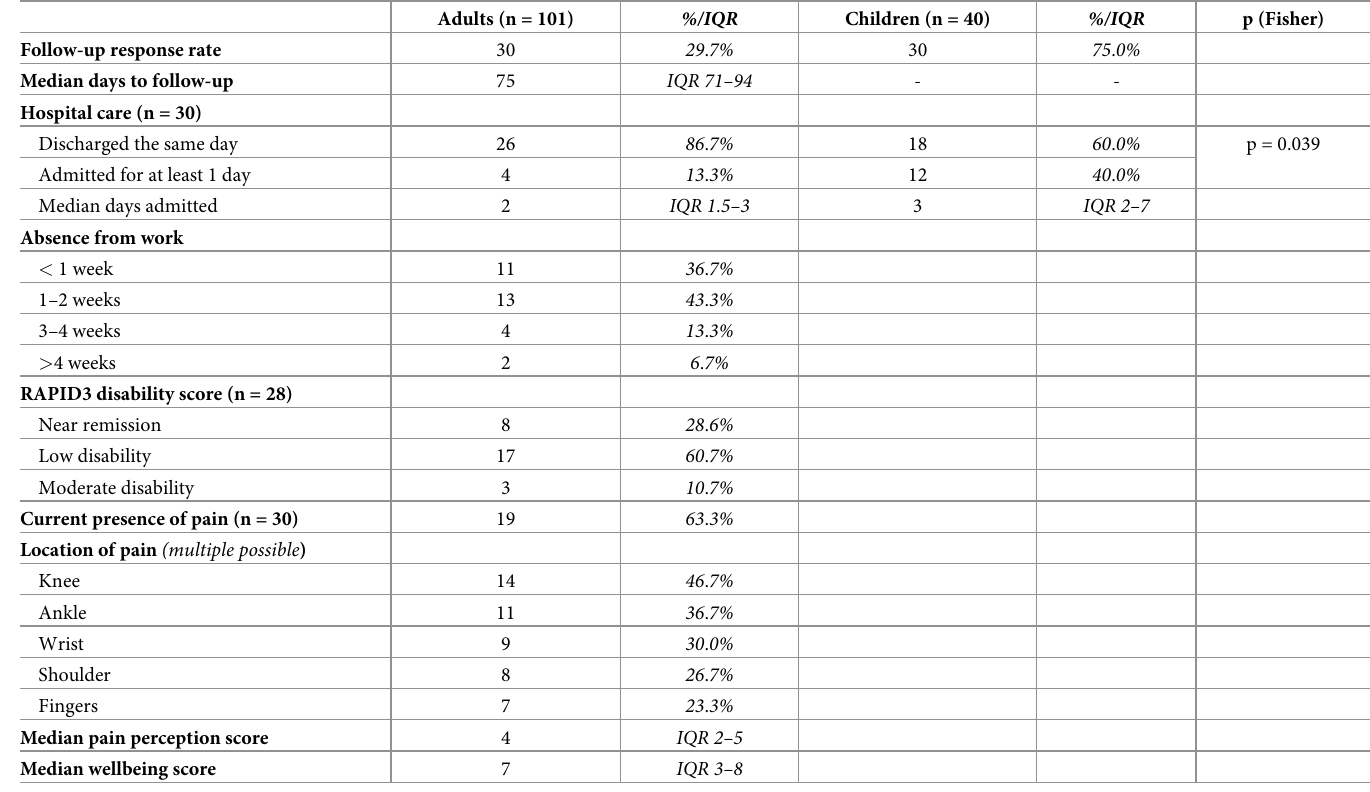
Table 4. Impact of CHIKV infection on work and disability 70–120 days after acute